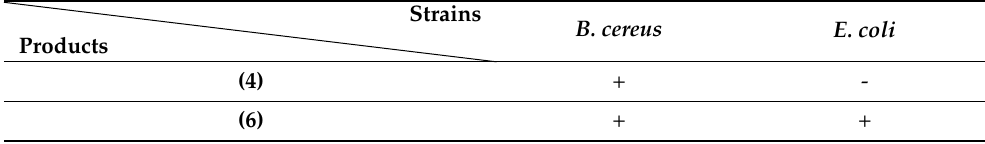
Table 4. Inhibitory activity of imidazo[4,5-b] pyridine derivatives ( 4 and 6 ).